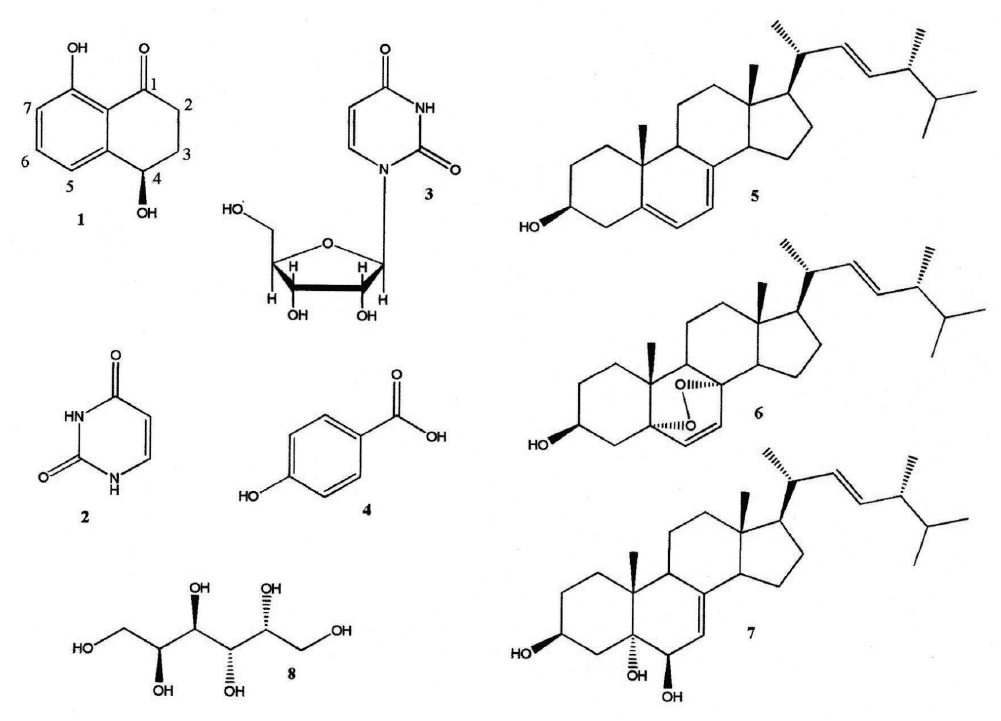
Figure 1 - Compounds isolated from Pestalotiopsis sp.